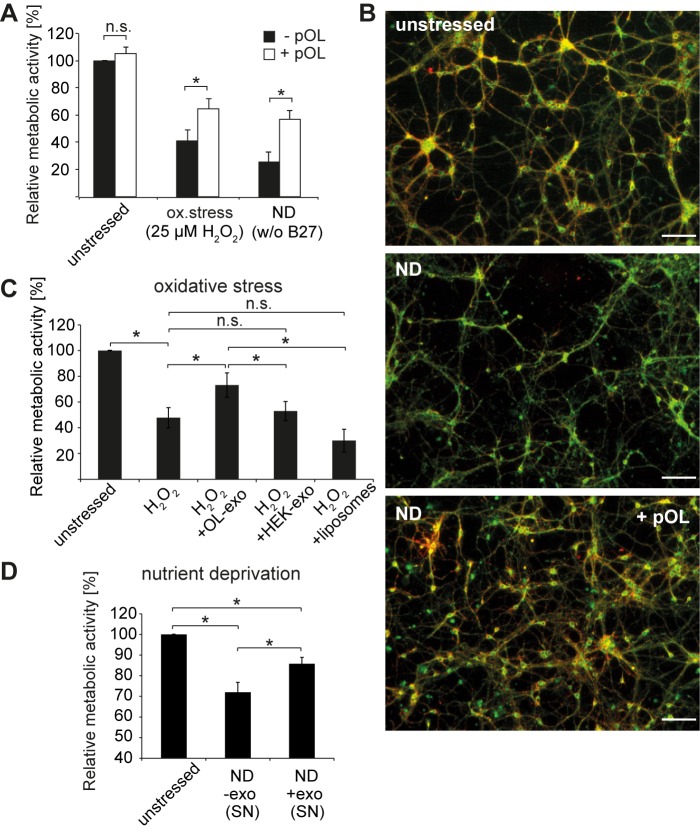
Neuroprotective role of oligodendroglial exosomes.(A) Boyden chamber co-culture of CN with or without pOL for 48 h under unstressed, oxidative stress, or nutrient deprivation (ND) conditions. Control CN cultured without pOL (black bars) were grown in oligodendrocyte-conditioned medium depleted from exosomes. Oxidative stress was induced after co-culture by challenging CN with 25 µM H2O2 for 1 h (n = 5). For nutrient deprivation, cells were cultured in medium lacking B27 supplement (n = 5). Neuronal viability was assayed by MTT assay. (B) Staining of the outer mitochondrial membrane with MitoCapture after nutrient deprivation and co-culture with and without pOL. Unstressed cells were grown in full medium without pOL. Scale bar, 100 µm. (C) Application of isolated exosomes and liposomes to neurons under conditions of cell stress. MTT assay of CN after single addition of isolated exosomes from pOL and HEK293T cells as well as liposomes 12–14 h prior to H2O2 stress (25 µM for 1 h) compared to unstressed or sham treated controls (n = 5). (D) MTT assay of CN subjected to nutrient deprivation and treated with exosome-containing (SN+exos) or exosome-deprived (SN w/o exos) oligodendrocyte culture supernatants for 12–14 h (n = 5). Error bars, SEM (n.s., not significant; * p<0.05; Wilcoxon-test).